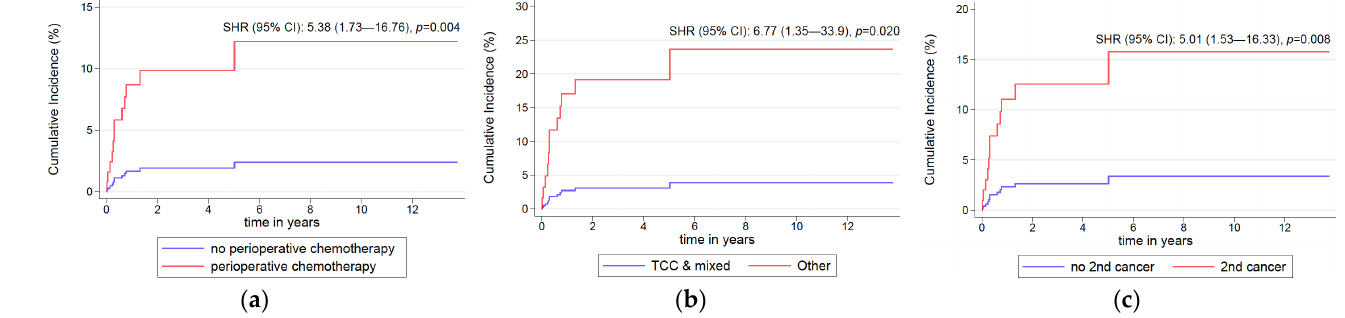
Figure 2. Competing-risks predicted cumulative incidence functions according to the presence of: ( a ) previous perioperative chemotherapy; ( b ) non-transitional-cell histology; ( c ) history of solid tumor other than urinary tract cancer (UTC). SHR: sub-distribution hazard ratio, CI: confidence interval.